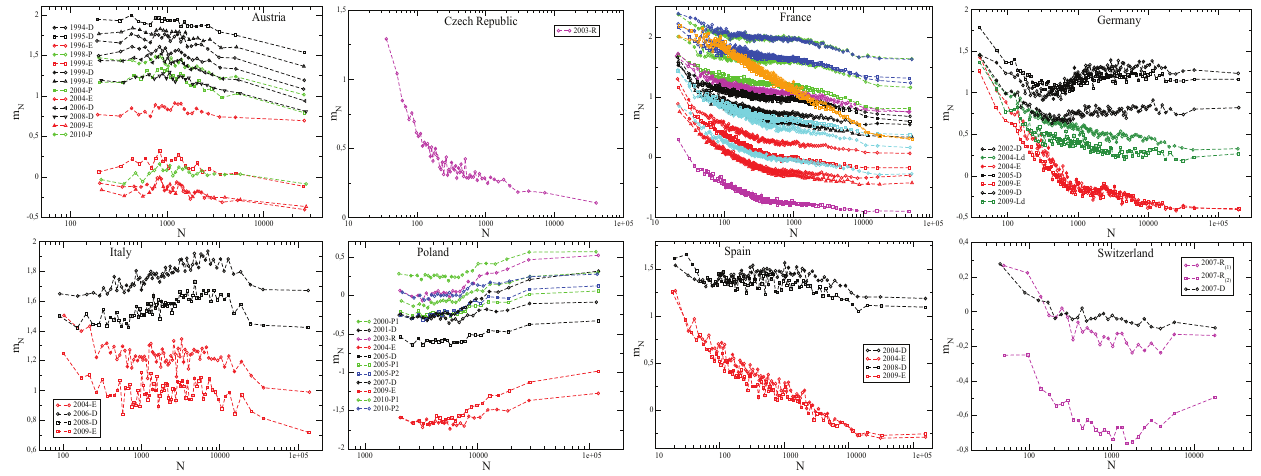
Figure 2. Average value, m N , of the conditional distribution P ( t D N ) . These quantities are obtained as averages over bins with 100 (200 for France) municipalities of size & N . See Fig. S1 in Appendix S1 for Canada, Mexico and Romania.